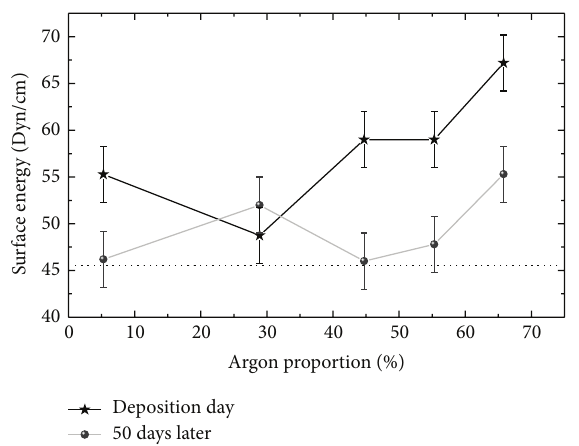
Figure 4: Surface free energy of the films deposited with different proportions of argon in the plasma. The dotted line represents the surface energy of the as-received PVC plate.